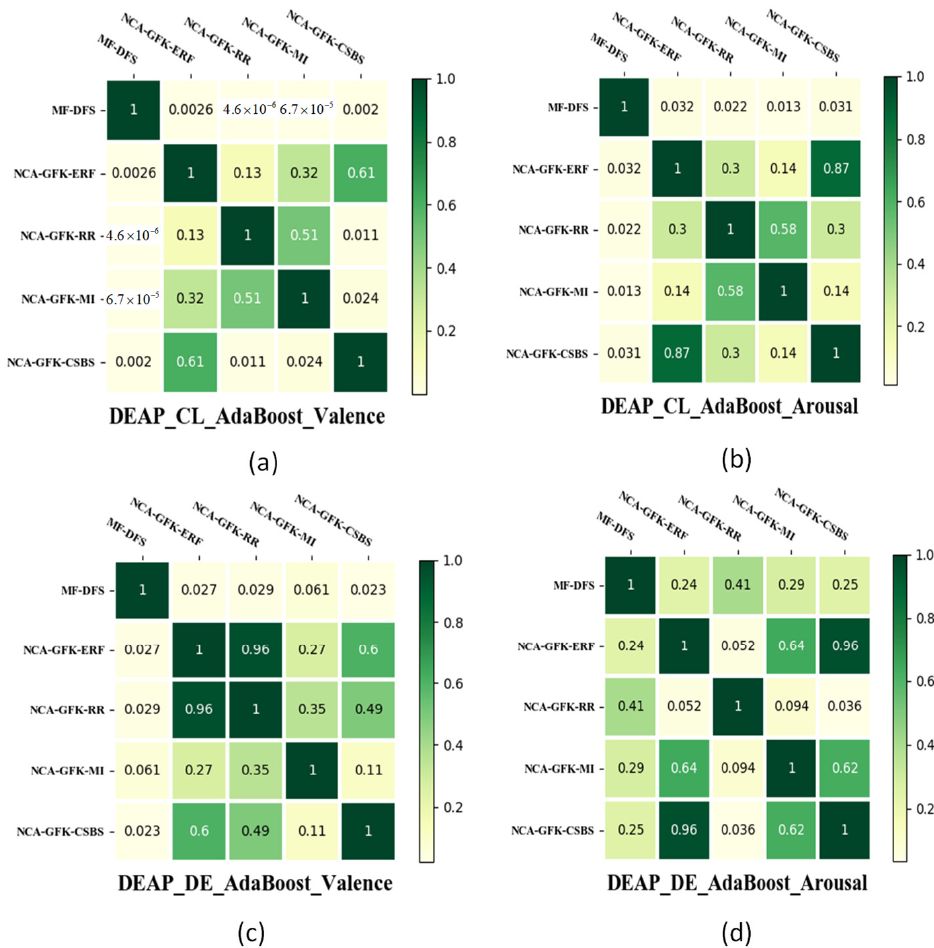
Figure 7. Heat map of the p -values of the paired t -test between different feature selection methods for the DEAP database. The p -values of CL features for the valence and arousal dimensions are shown in ( a , b ), respectively. The p -values of DE features for the valence and arousal dimensions are shown in ( c , d ), respectively.